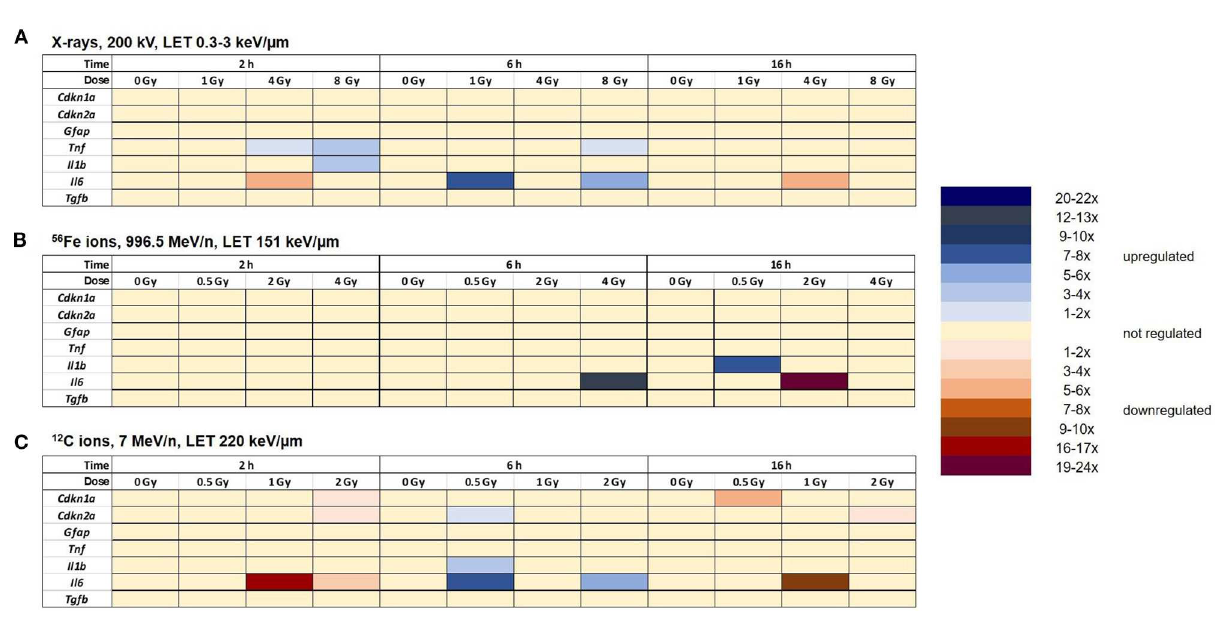
FIGURE12 Radiation exposure of astrocytes discretely regulates the expression of some selected target genes without clear dose- and time-dependency. Expression of selected target genes in primary murine astrocytes at different time points after exposure to X-rays ( n = 4) (A) , Fe ions ( n = 4) (B) and C ions ( n = 4) (C) was analyzed using RT-qPCR ( n = 4) as described in Section 2.6.2. The samples were compared by one-way-ANOVA. Expression of significantly regulated target genes ( p < 0.05) is shown by a color code for each gene, dose and time